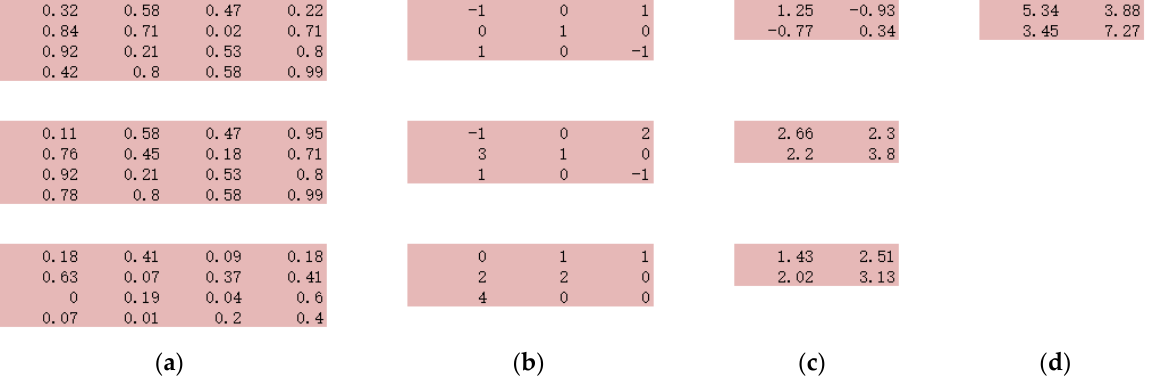
Figure 2. Convolution operation for input with multiple channels. ( a ) 3 × 4 × 4 arrays, ( b ) a three- dimension filter, ( c ) the output arrays after filtering the three channels one by one, and ( d ) the final output array with values being the sum of values on the depth